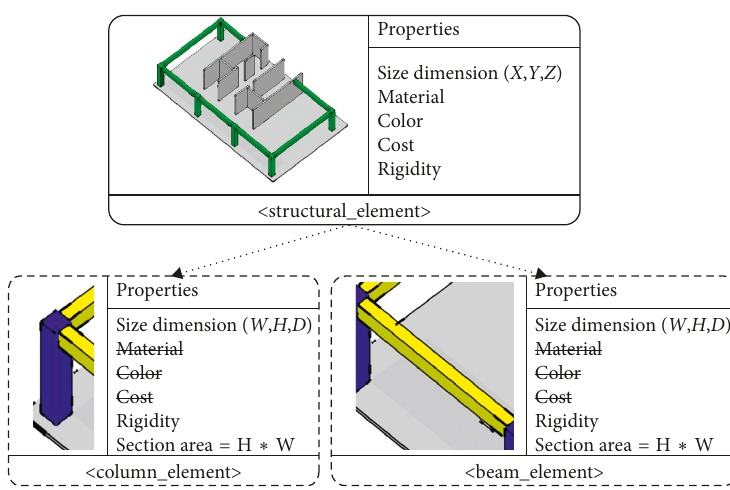
Figure 12: Enriched representation by the structural engineer of the BIM interpreter.